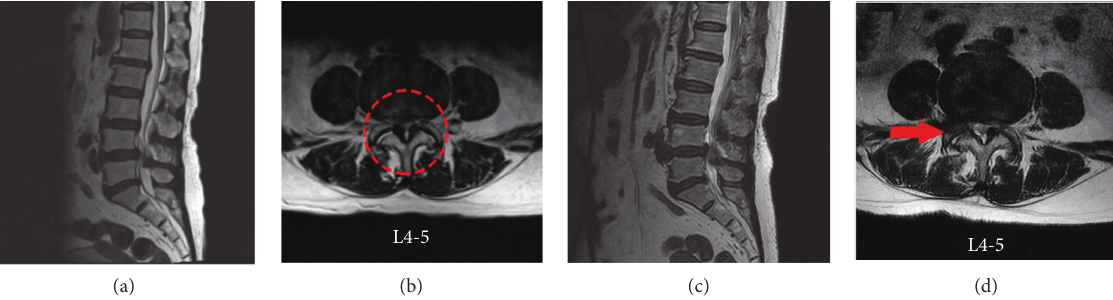
Figure 2: MRI scans of a case with lumbar stenosis at L4-5 with “U” route PELD. (a, b) Preoperative sagittal and cross-sectional MRI images, the lumbar stenosis, and disc herniation are indicated by the red circle. (c, d) Postoperative MRI images are showing ventral and dorsal decompression. The red arrow indicates that the removal of partly ventral osteophyte of SAP, herniated NP, and hypertrophic LF at L5.